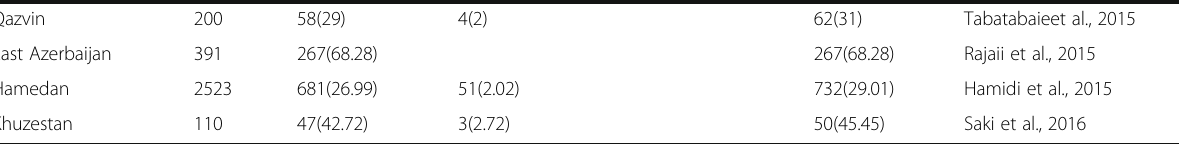
Table 3 Pregnant women group baseline characteristics of included studies (Continued)